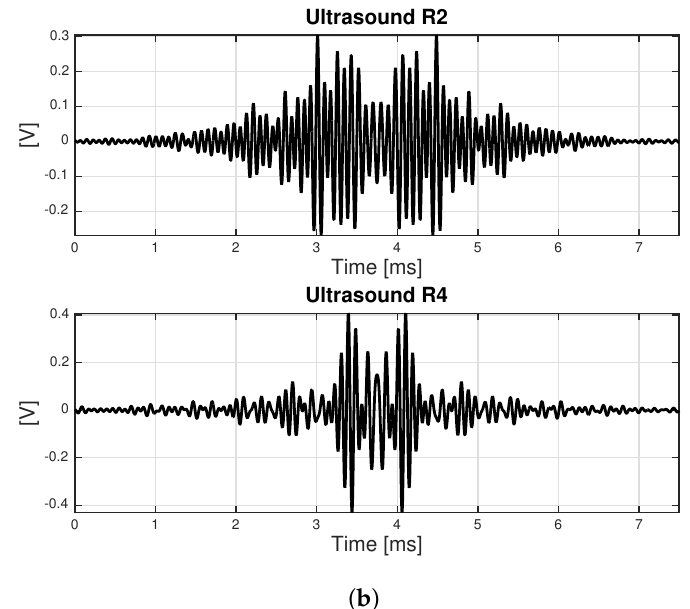
Figure 7. Sensors recordings in passive configuration, 1 buffer triggered by A1: ( a ) accelerometers and ( b ) ultrasound transducers.